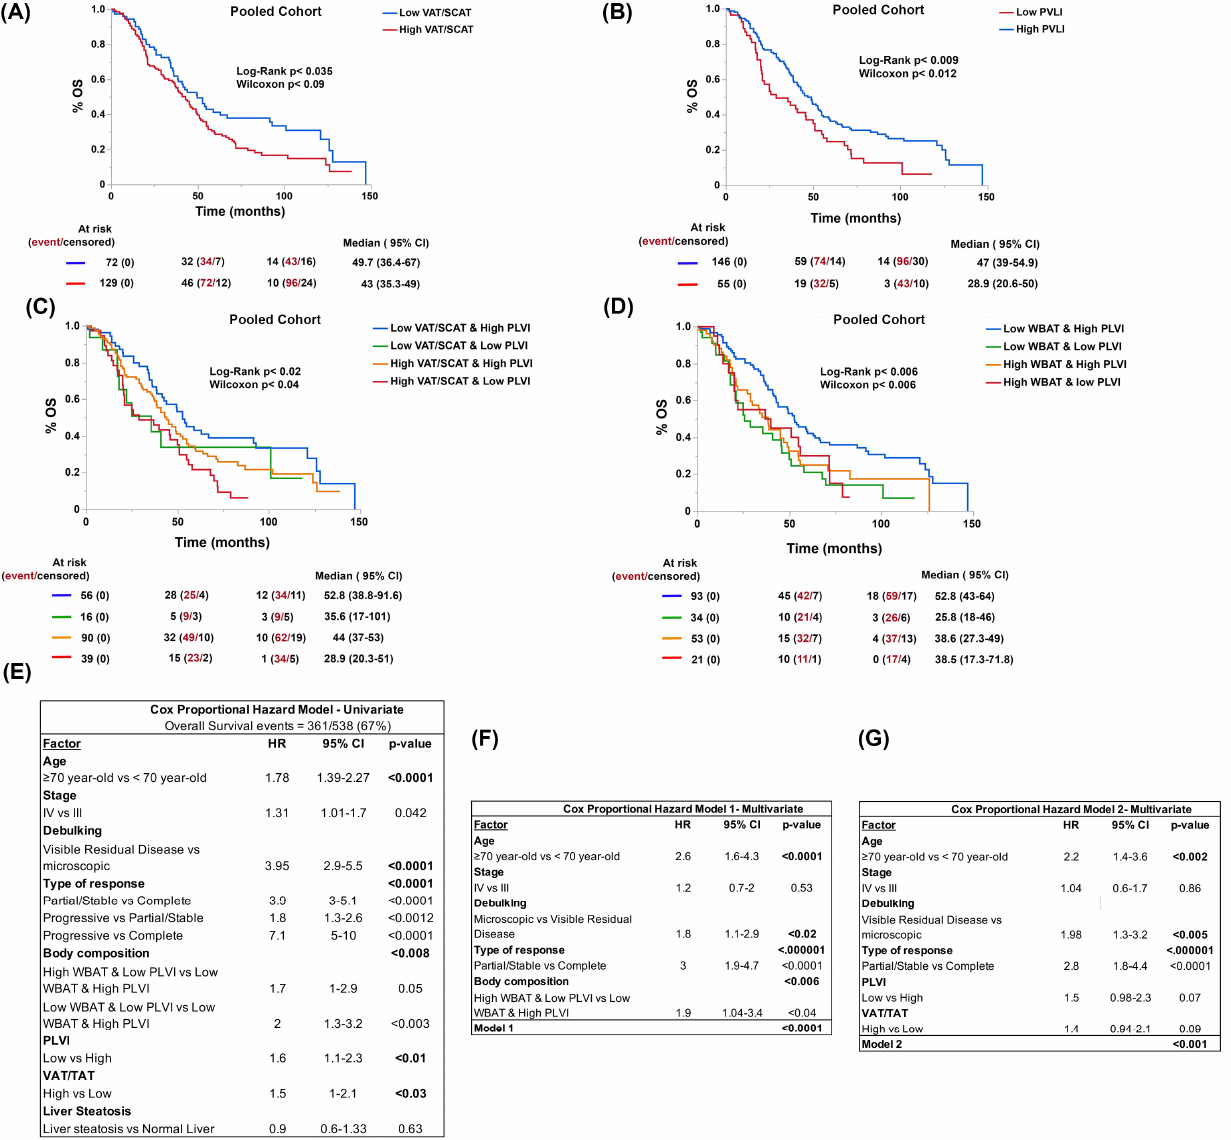
Figure 3. Overall survival (OS) curves depending on visceral to subcutaneous adipose tissue ratio (SCAT at same level) ( A ), PLVI ( B ), and BCs defined by VAT/SCAT ( C ) or WBAT ( D ) and PLVI, respectively. Univariate Cox regression analyses ( E ) and multivariate Cox-regression models ( F ) built up with prognostic factors ( E – G ) in the pooled cohort.